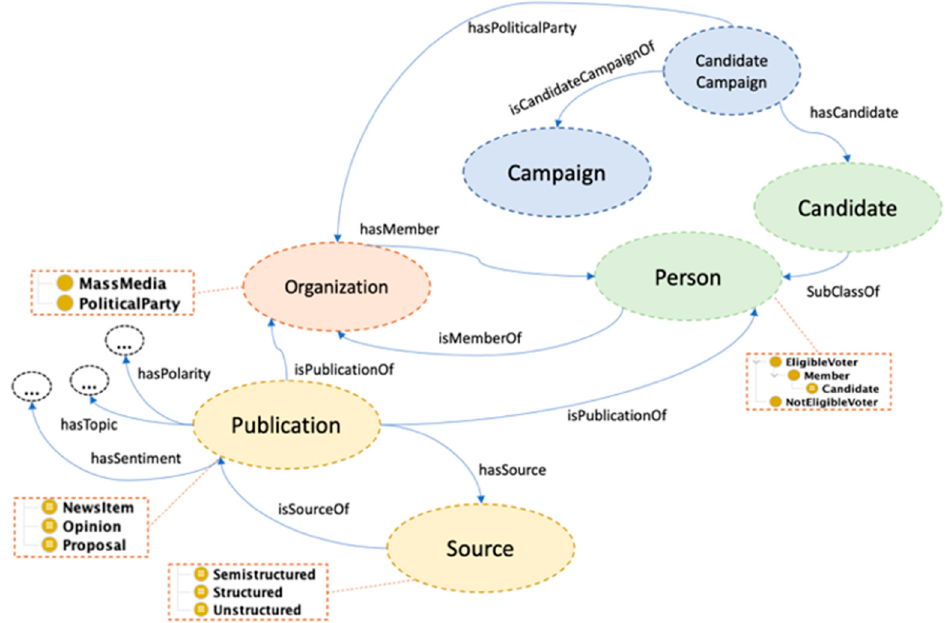
Figure 2. Ontology’s high-level classes and their relationships.